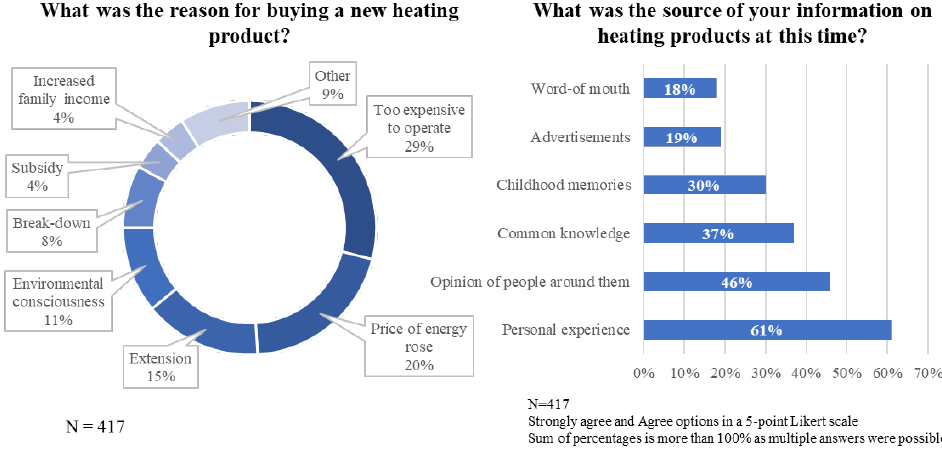
Figure 5. The customers initial purchase situation and the influence of sources of information.